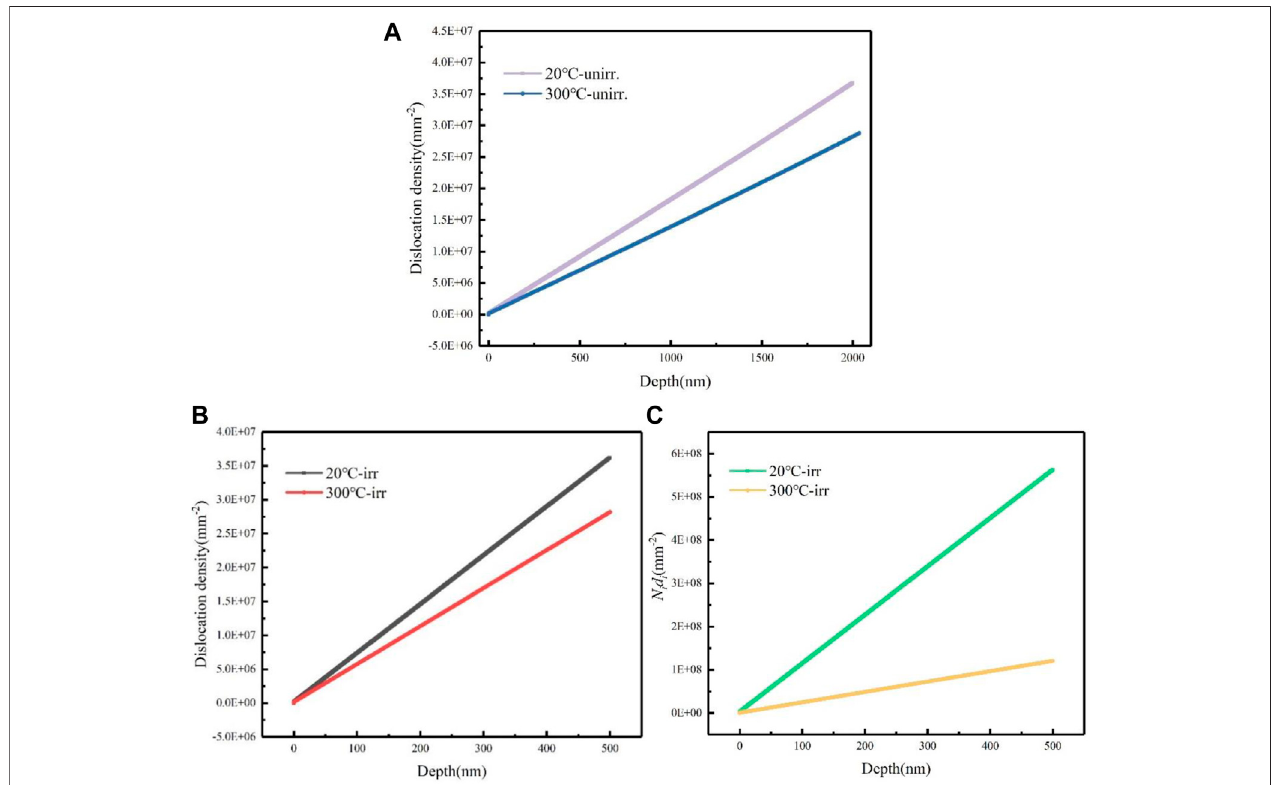
FIGURE 14 | The dislocation density or dislocation loops changes with depth (A) under unirradiated conditions with the depth of 2000 nm (B) under irradiated conditions with the depth of 500 nm (C) the product of the diameter and density of the dislocation loops ( N α i d α i ) changes with depth.